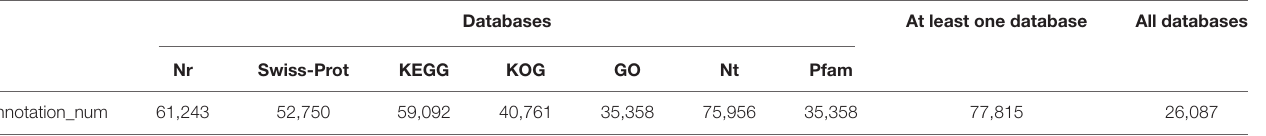
TABLE 4 | Annotation results of seven